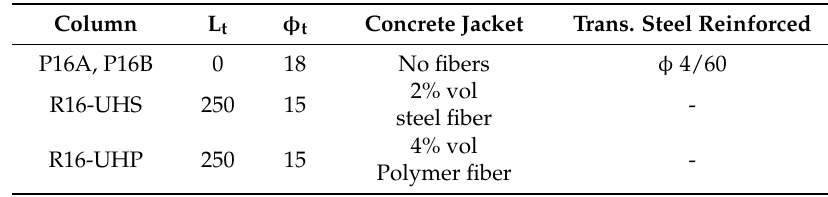
Table 4. Reinforced concrete (RC) pier scaled 1:6 (columns): Length (L t ) and diameter ( φ t ) of the turned rebar segments (mm); HPFRC jacket with steel (UHS) or polymer (UHP) fibers. Vol is the volumetric fraction of fibers. L t φ